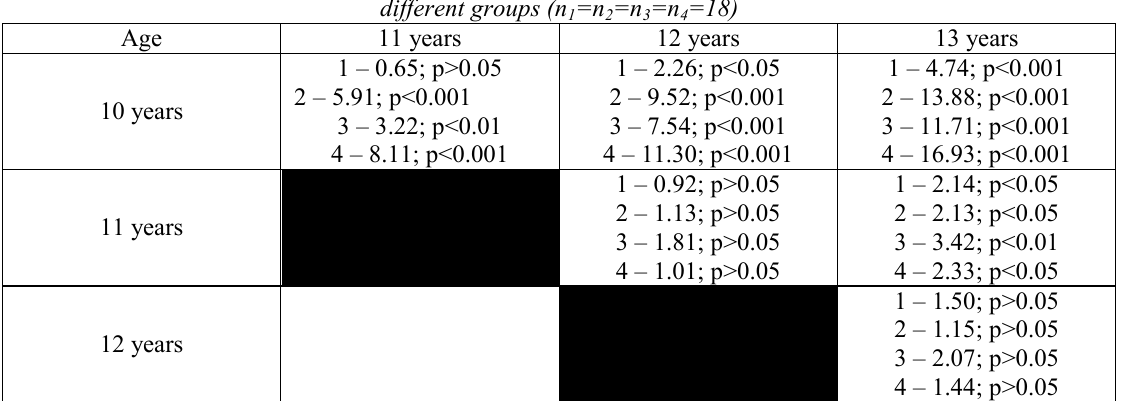
Matrix of indices changes reliability of flexing and extension arms support lying on the floor of boys aged 10-13